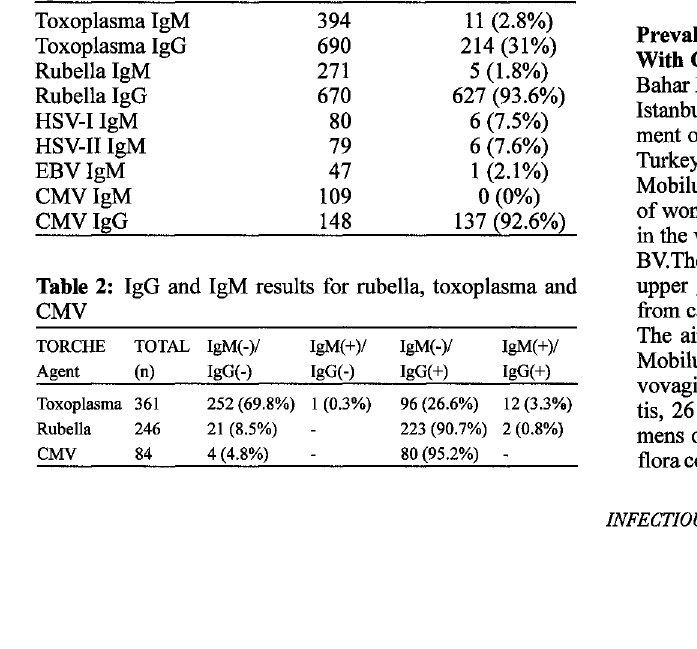
Table 1: TORCHE seropositivity among pregnant women Specific antibodies